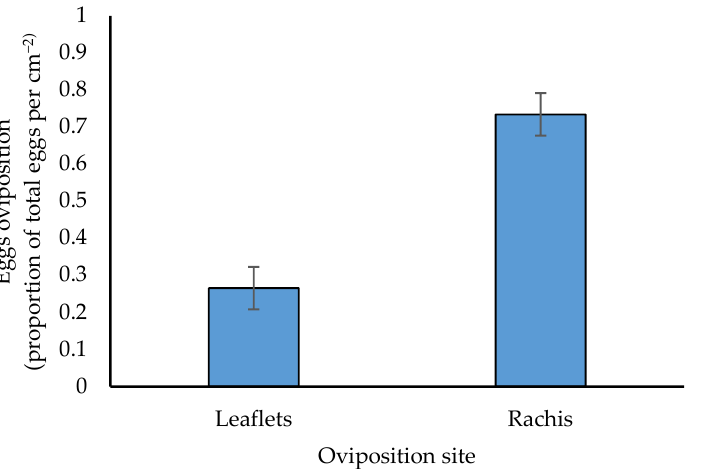
Figure 4. Oviposition site preference (proportion of total eggs per cm − 2 palm area) of O. lybicus . Predicted means with standard error bars were derived by generalized linear model with binomial distribution with link function of logit ( p < 0.001).